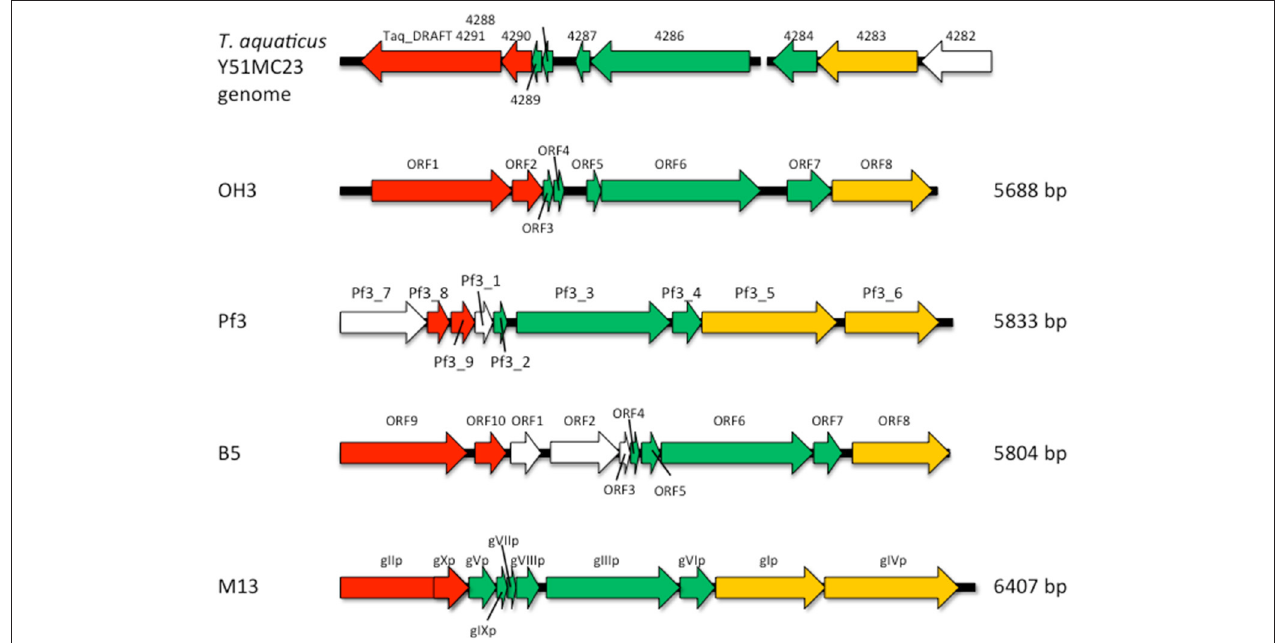
FIGURE 8 | Comparison of the genome organization of phage ϕ OH3 with that of the phage Pf3, B5, M13, and T. aquaticus Y51MC23 genomes. Open reading frames with similar functions are indicated using the same color scheme used in Figure 4 . White arrows show regions encoding hypothetical proteins with unknown